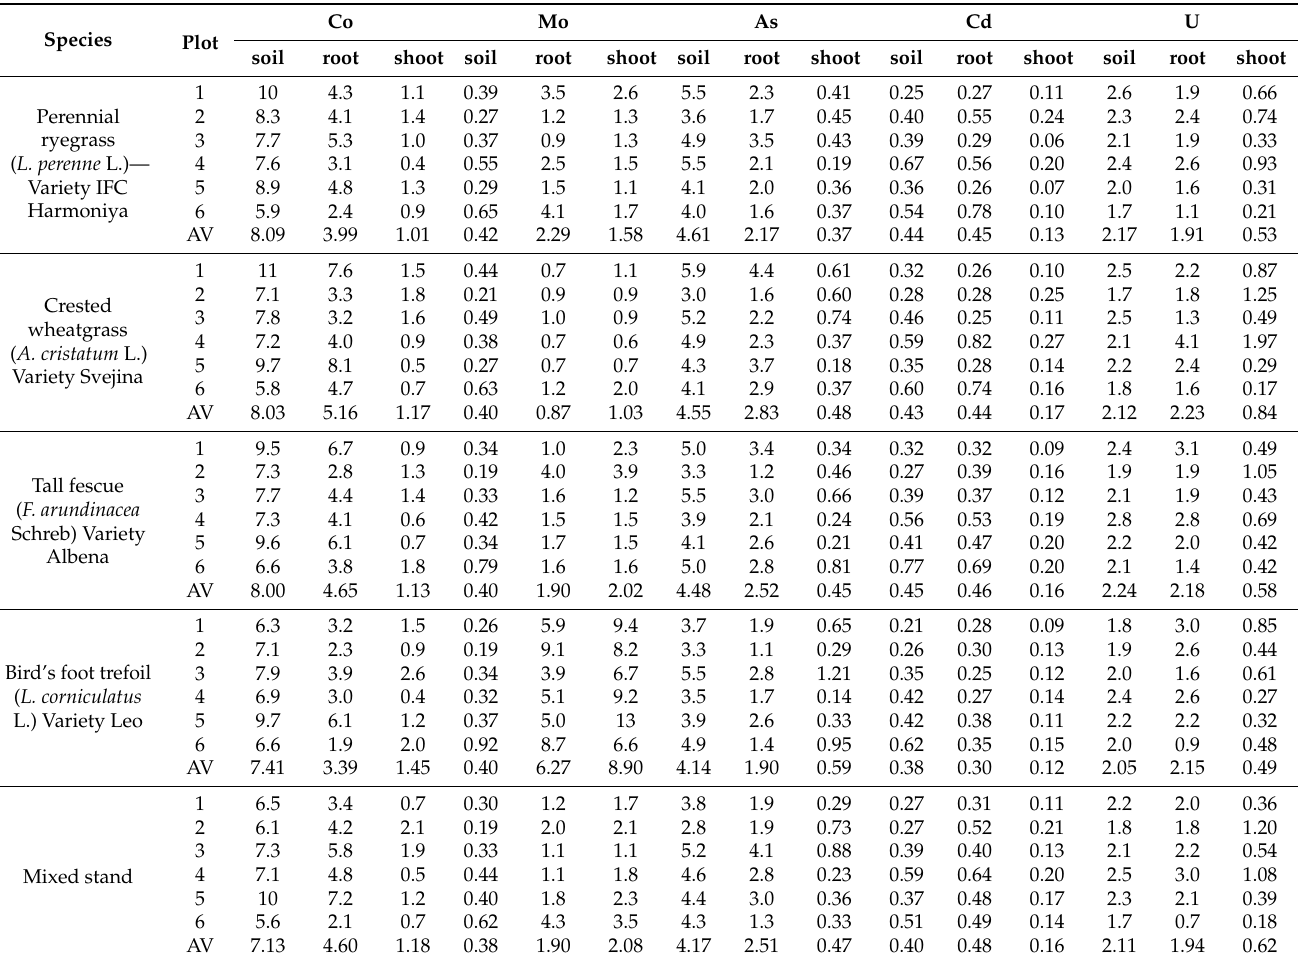
Table 5. Contents of Co, Mo, As, Cd, and U in urban soils and plant roots and shoots